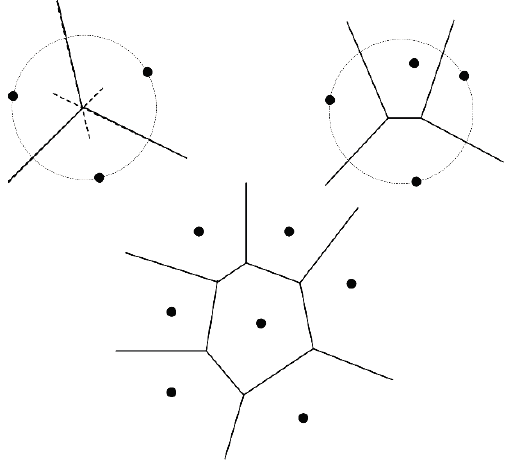
Figure 3. Examples of some Voronoi